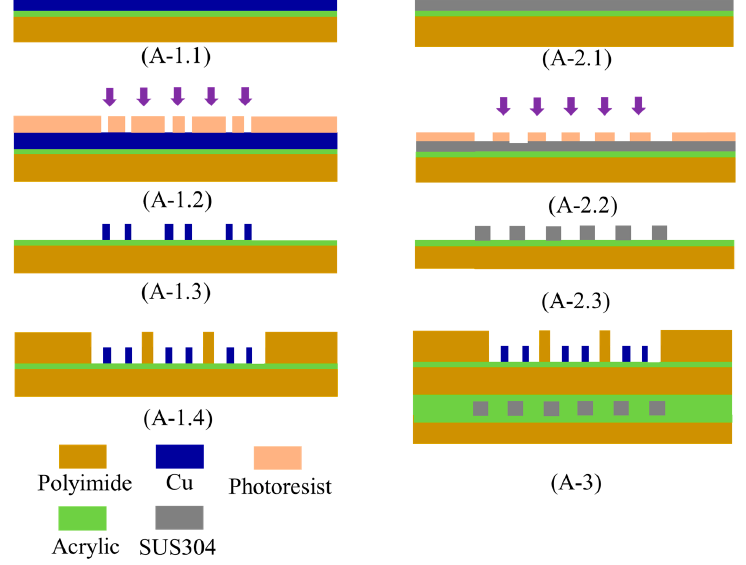
Figure 3. Fabrication process of PEG/MWCNTs gas sensor.